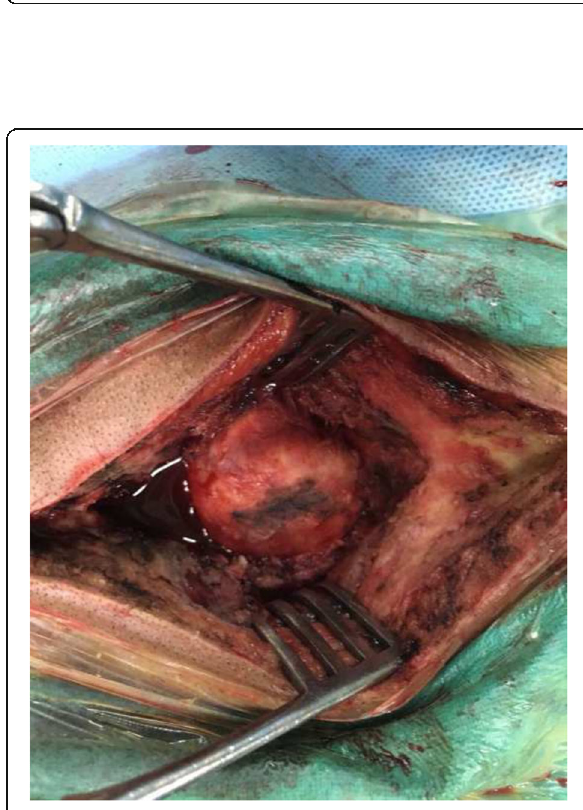
Fig. 3 Showing intraoperative picture of the cyst in intermuscular space in the sub-occipital